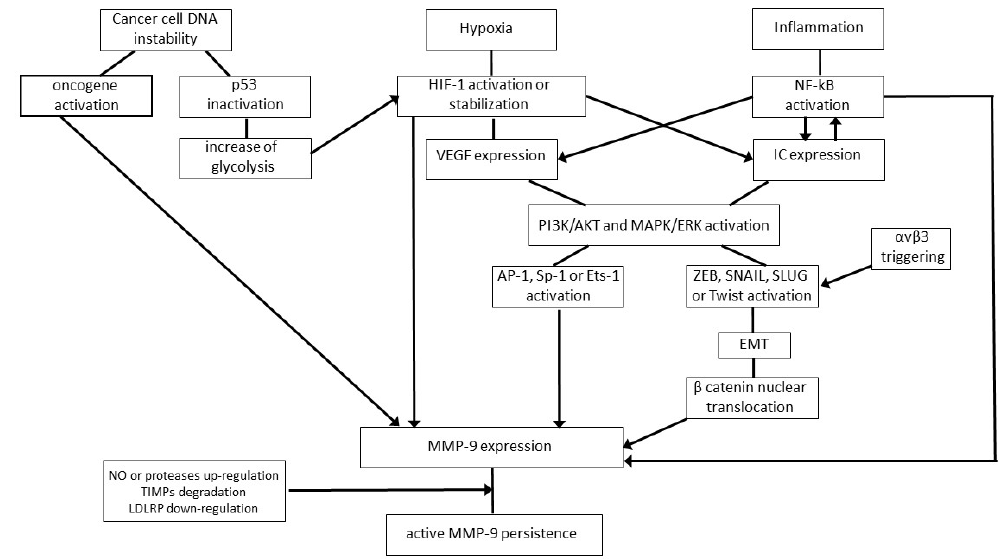
Figure 2. Molecular events promoting the expression and persistence of MMP-9 in tumor tissues. Summary of the molecular pathways leading to MMP-9 overexpression in a wide variety of human tumors. Arrows symbolize directions of connections. Abbreviations: AKT, protein kinase B; AP, activator protein; EMT, epithelial-to-mesenchymal transition; ERK, extracellular-signal-regulated kinase; HIF, hypoxia-inducible factor; IC, inflammatory cytokines; LDLRP, low-density lipoprotein receptor-related protein; MAPK, mitogen-activated protein kinase; MMP, matrix metalloproteinase; NF-kB, nuclear factor-kappa B; NO, nitric oxide; PI3K, phosphoinositide 3 kinase; Sp, specificity protein; TIMP, tissue inhibitor of matrix metalloproteinase; VEGF, vascular endothelial growth